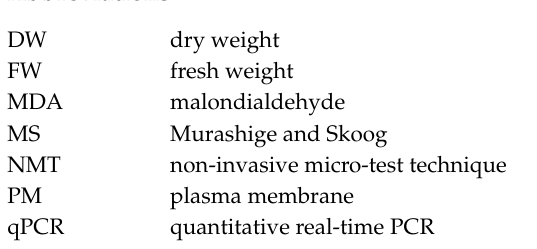
Table S1. Primers for LrKUP8 isolation, LrKUP8 expression, and OE- LrKUP8 callus detection; Figure S1. DNA integration analysis to identify LrKUP8